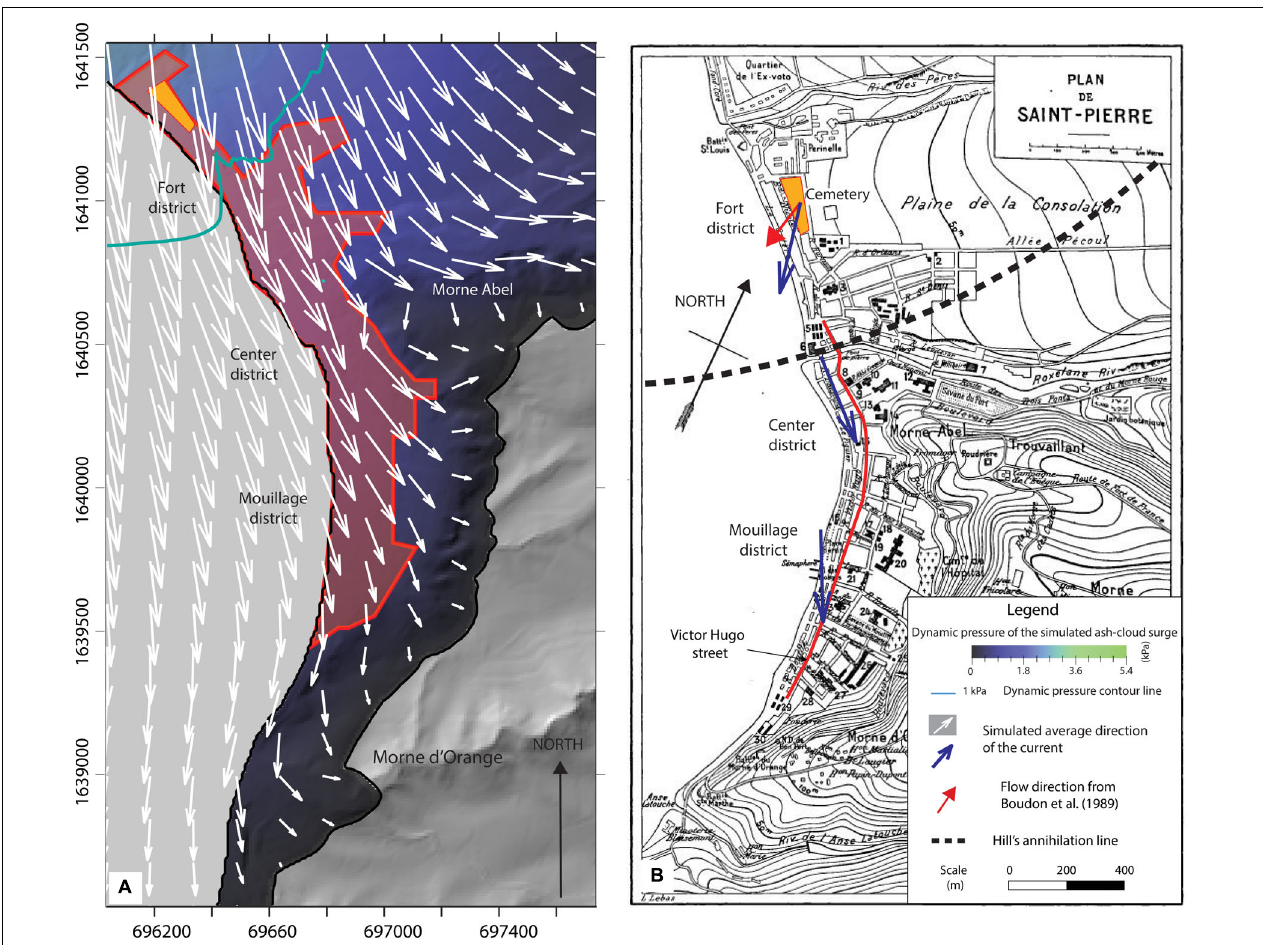
FIGURE 9 | Zoom of St Pierre’s area showing the maximum dynamic pressure and the mean direction of the ash-cloud surge from the best-fit simulation: (A) superimposed over the DEM and polygon of the city as mapped by Lacroix (1904), (B) superimposed over the topographic map of the city, showing directions of the simulated current (blue arrows) facing Victor Hugo street (red